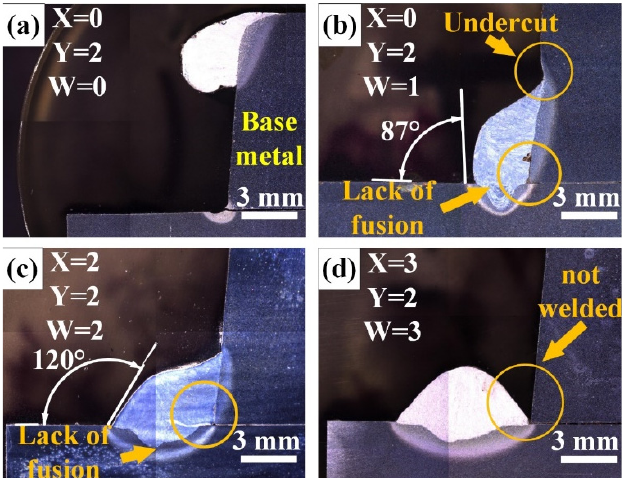
Figure 4. Macroscopic morphology of the weld with traditional distribution (X = 0, Y = 2 mm).